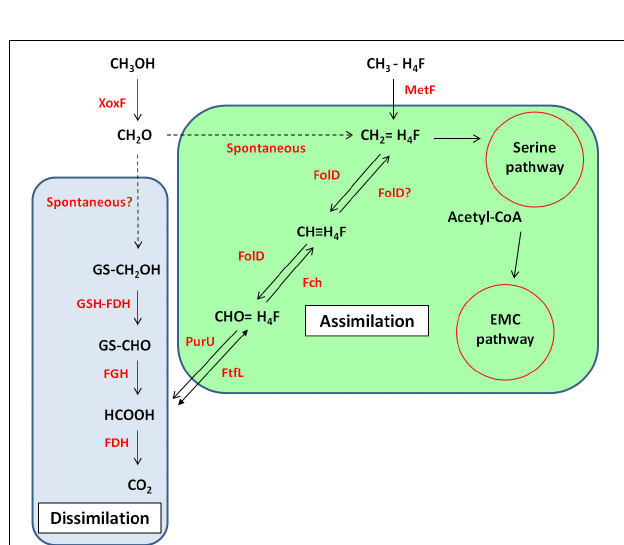
FIGURE 3 | Predicted metabolic pathway of methanol metabolism in strain La 6 based on genome sequence analysis. Enzymes are shown in red whilst compounds and names of pathways are in black. Solid arrows indicate enzymatic reactions, dashed arrows indicate reactions are non-enzymatic or unknown. Reactions within the blue/green box are part of the dissimilatory/ assimilatory pathway. XoxF, methanol dehydrogenase; GSH-FDH, glutathione-dependent formaldehyde dehydrogenase; FGH, S -formylglutathione hydrolase; FDH, formate dehydrogenase; PurU, 10-formyl-H 4 F hydrolase; FtfL, formyl-H 4 F ligase; FolD, bifunctional methylene-H 4 F dehydrogenase- methenyl-H 4 F cyclohydrolase; Fch, methenyl-H 4 F cyclohydrolase; MetF, methyl-H 4 F reductase; EMC, ethylmalonyl-CoA; PHB,